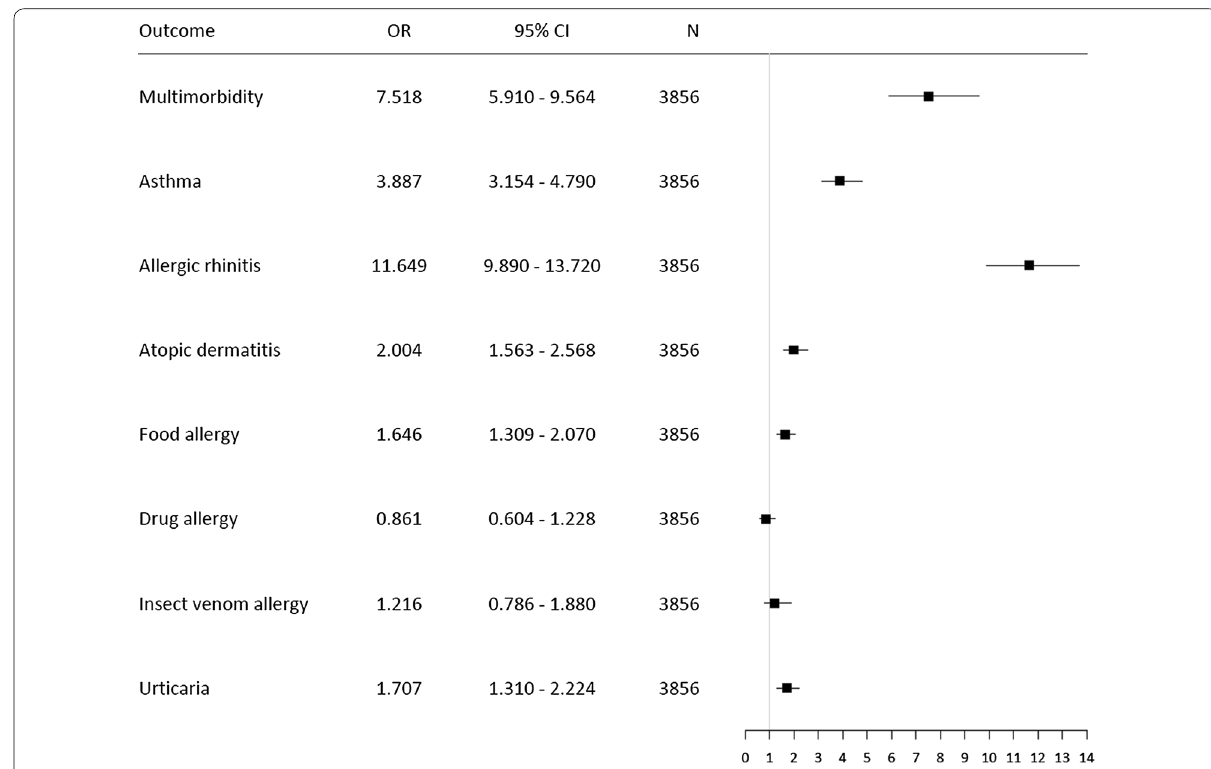
Fig. 3 The influence of diseases on risk of allergic polysensitization assessed by skin prick